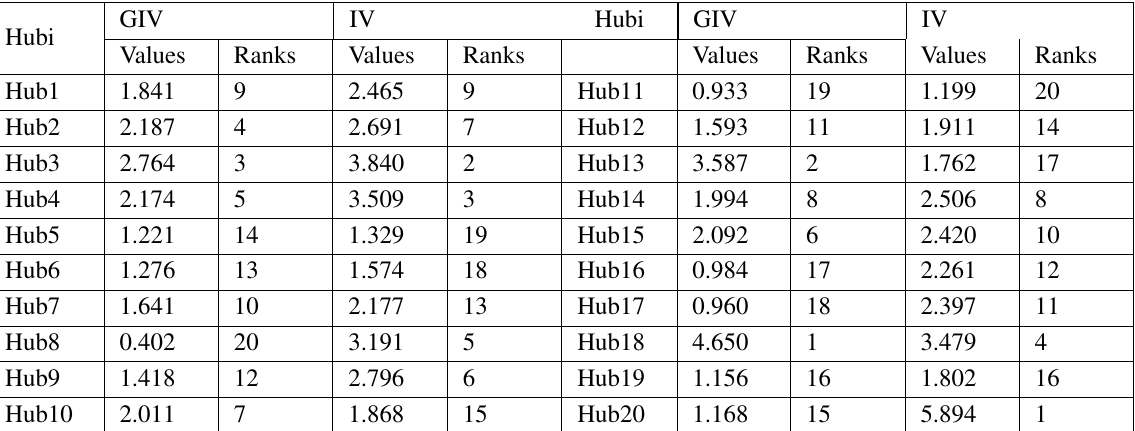
Table 4. Importance and connectivity values and ranks of